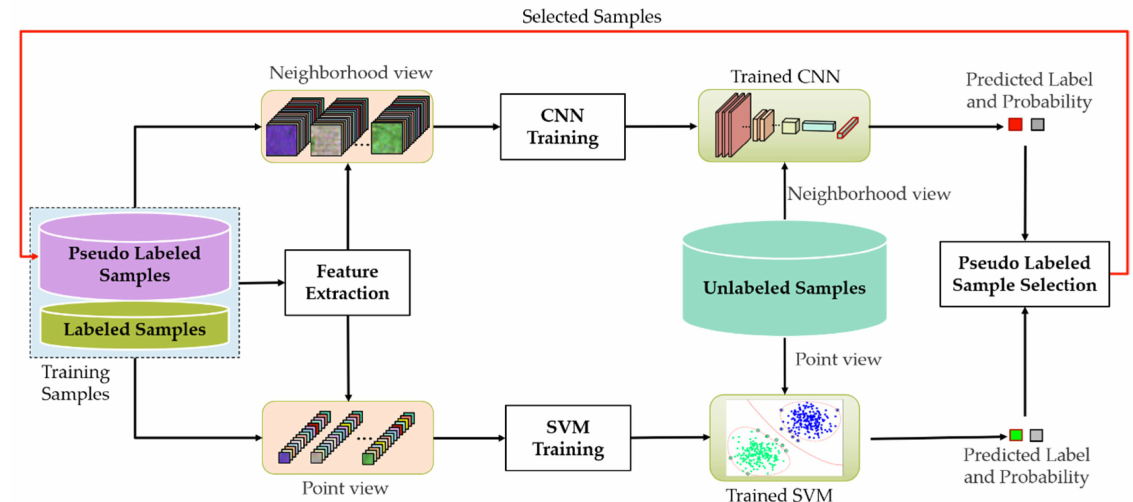
Figure 1. Flowchart of the proposed method.